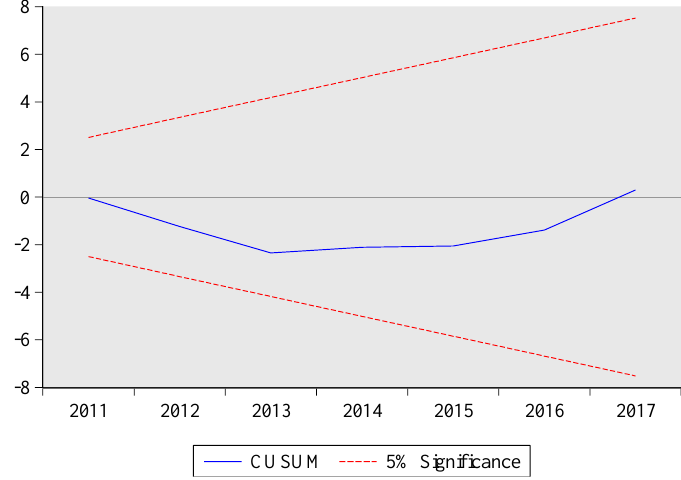
Figure 5. CUSUM test for Model 2. The plot of the cumulative sum of recursive residuals. Note: The red dashed lines represent the critical bounds at the five percent significance level.